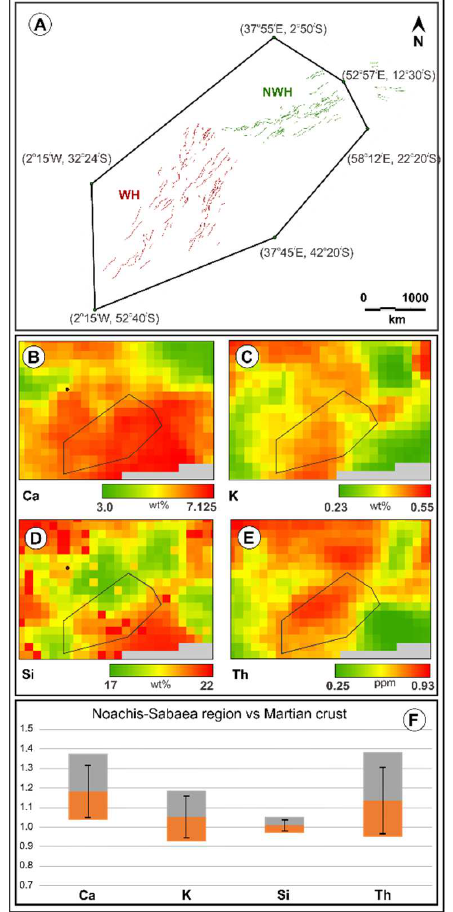
Figure 7. ( A ) Areas with pervasive extensional structures selected for GRS analysis. The coordinates of each corner of the hexagonal area are stated parenthetically. ( B – E ) The concentrations of Ca, K, Si, and Th, with the study region outlined (global maps are provided in Supplementary Figures S1 and S2). Mass fractions are percentages except for Th in mg/kg. The study region’s geochemistry compared with the rest of the Martian crust, following the modified box plot method. ( F ) The ratios are shown as 25th/75th percentile (orange), 50th/50th percentile, and 75th/25th (grey) percentile [61]. The error bars were calculated by propagating the median average deviations (MAD), where MAD = median (|Xi–median (Xi)|) [62]. notable deviations from the two interchangeably and what constitutes the rest of Mars.